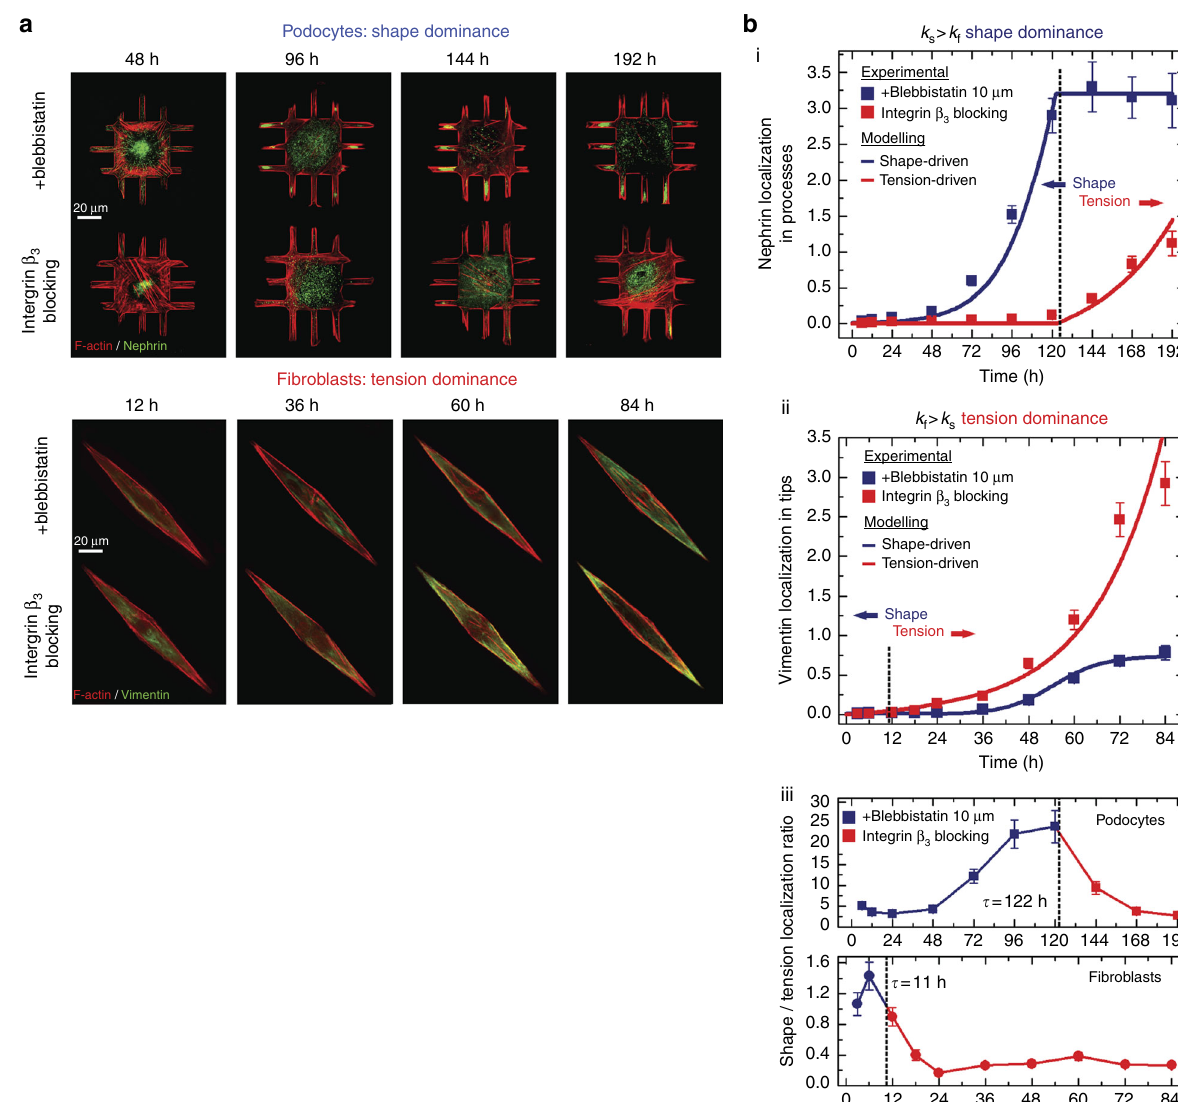
Reaction-diffusion dynamics transduce shape signals . To understand the physicochemical mechanisms that enable integrin β 3 to act as an effective shape receptor, we developed a partial differential equation-based dynamical model of integrin activa- tion and the downstream signal fl ow (Fig. 7a). We used Virtual Cell (VCell) 37 to build a spatially-speci fi c model of biochemical reactions that can dissect and quantify the respective contribu- tions of individual molecular attributes to relevant phenotypic changes, i.e., protein localization (see Supplementary Note 4 for details). To parameterize the model with experimentally measured values of the individual integrin subtypes, we quanti fi ed the